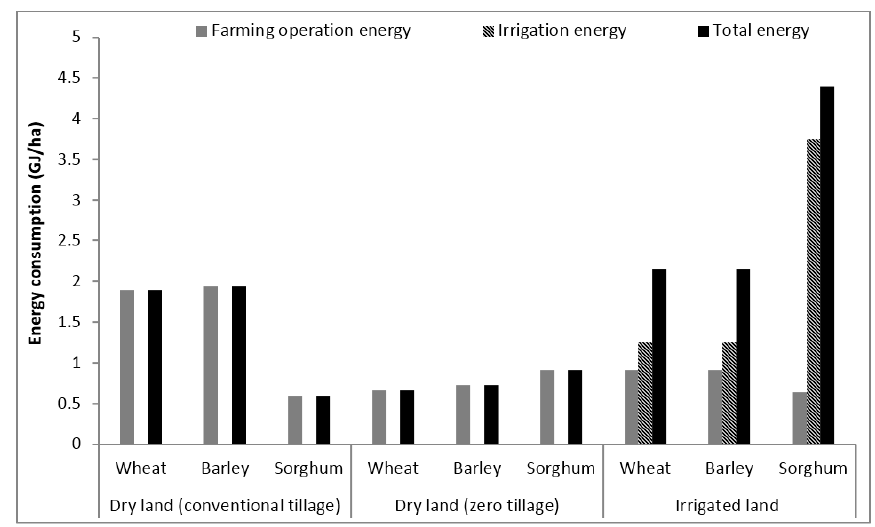
Figure 3. Energy consumption (GJ/ha) for three high value grain crops in Southern Grain Region. Table 8. Energy consumption (GJ/ha) for three high value grain crops in Western Grain Region.